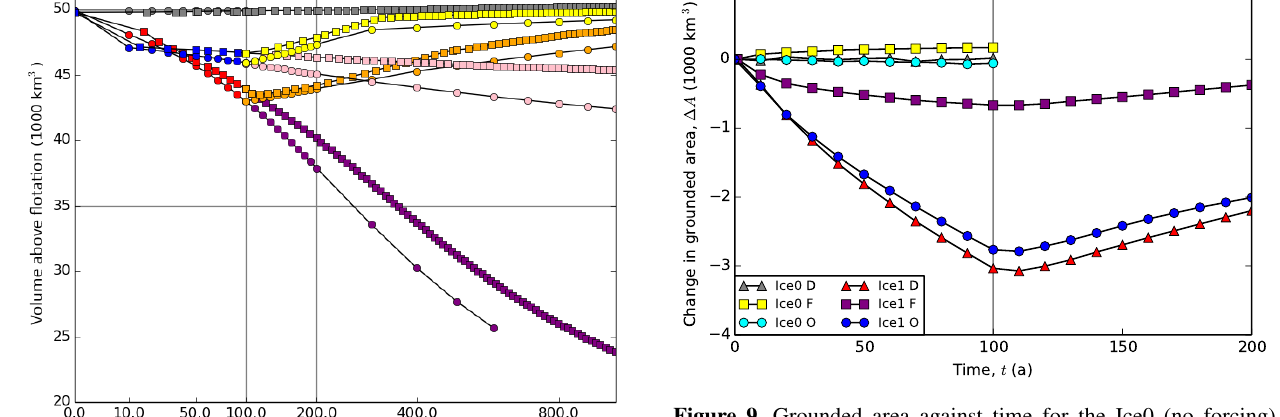
Figure 9. Grounded area against time for the Ice0 (no forcing) and Ice1 (basal melting) experiments with no-damage model (BISI- CLES) and the damage model (BISICLES_D) of Sect. 2.2 (IceD0, IceD1r) compared to a simulation where the damage field does not evolve with time but is taken from the initial state of IceD0 (IceF0, IceF1). In the no-forcing experiments, the model with fixed damage (IceF0) produces a near-steady state close to that of Ice0 and IceD0. In the forcing experiments, the retreat of the grounding line in the fixed damage model (IceF1r) is much slower than in the model with evolving damage (IceD1r) and the model without damage and larger A